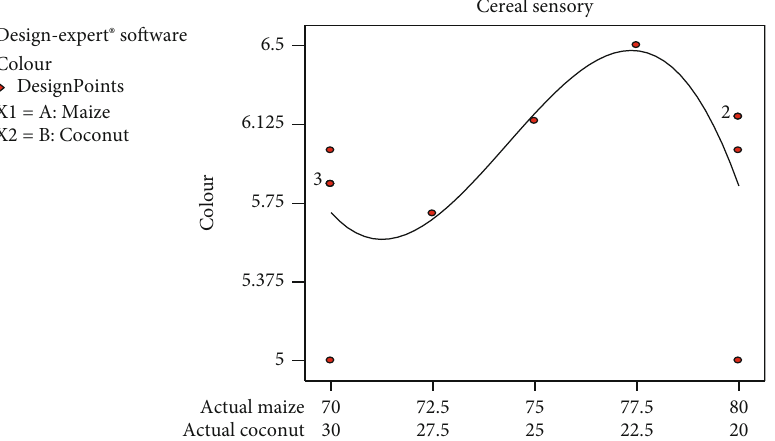
Figure 2: Mean graph for colour sensory responses on the